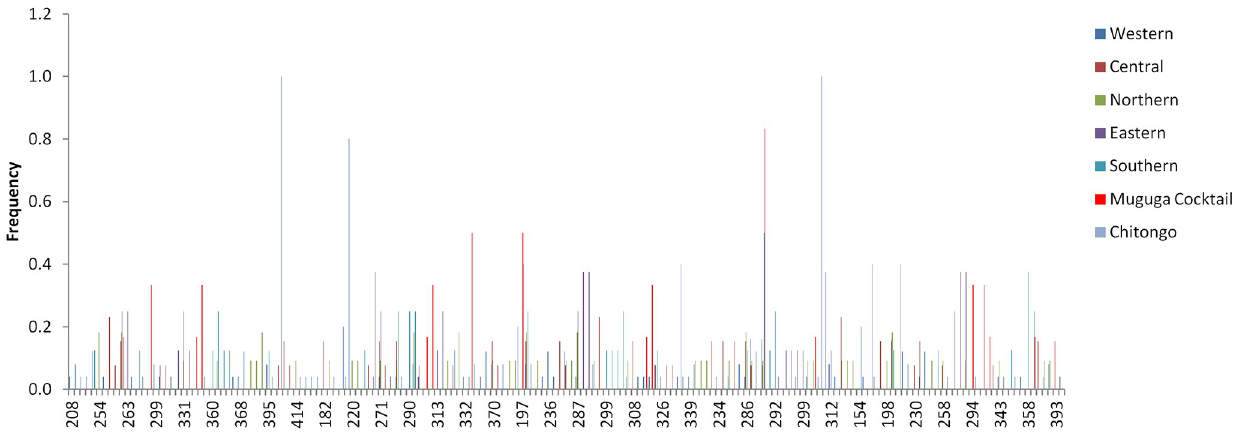
Fig 8. Overall allele frequencies from Burundi field samples together with the Muguga cocktail and Chitongo vaccine stocks showing the presence of both shared and unique alleles. Predominant alleles were calculated as proportions of the total of each satellite marker and histograms were generated from the multi-locus